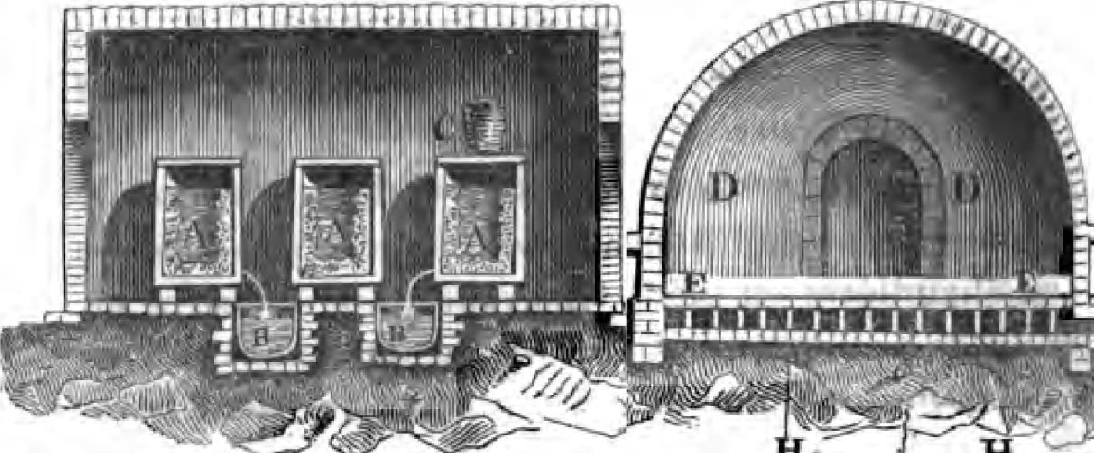
Figure 7. A section of the ‘lagone coperto’ (covered geothermal lake).